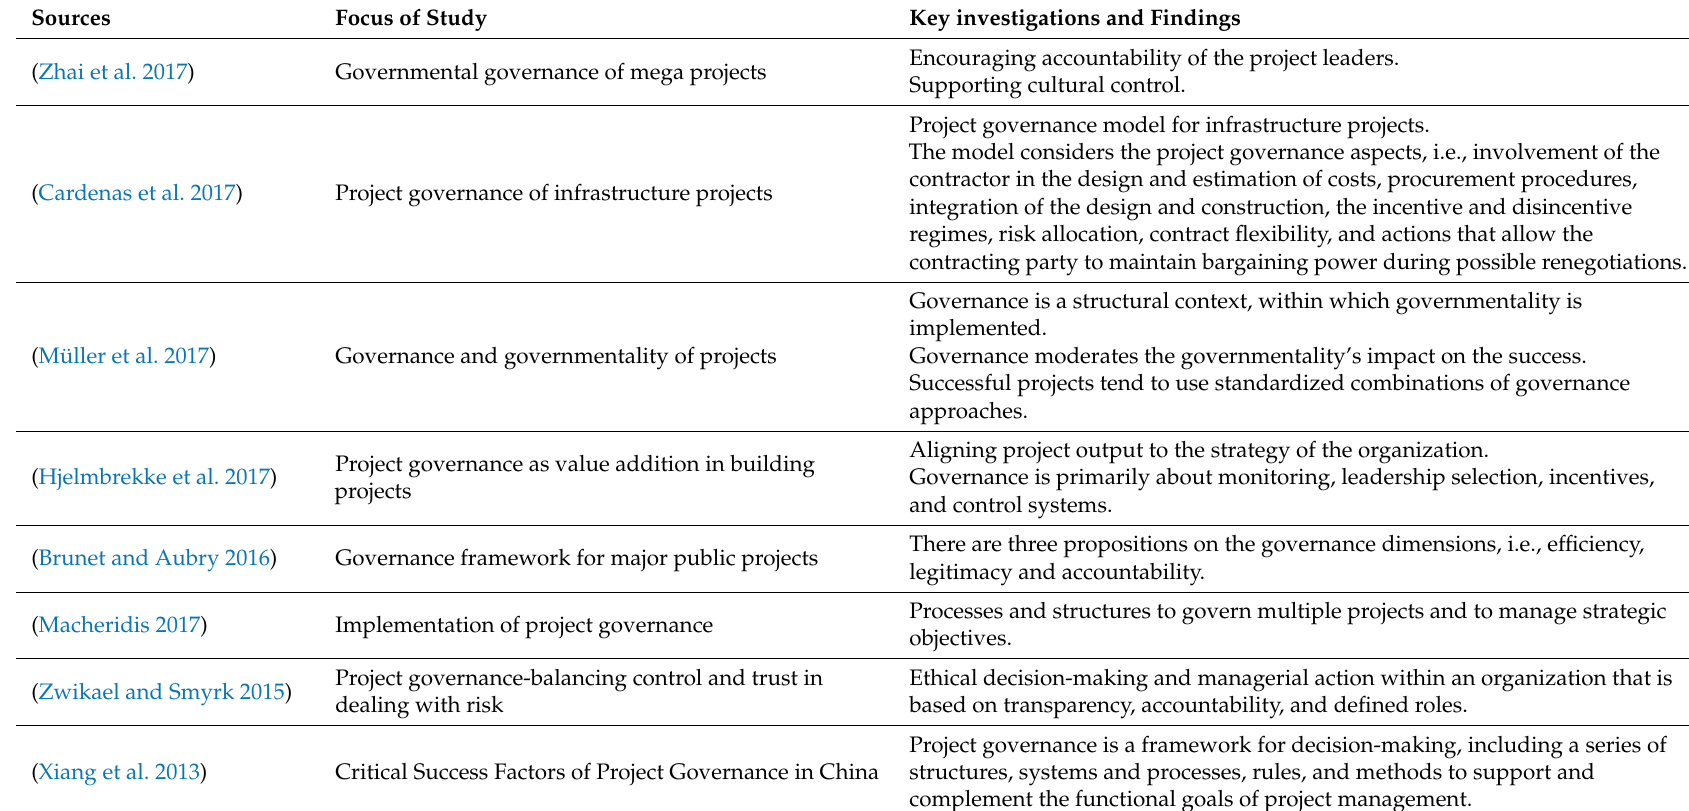
Table 1. Summarized findings on the role of project